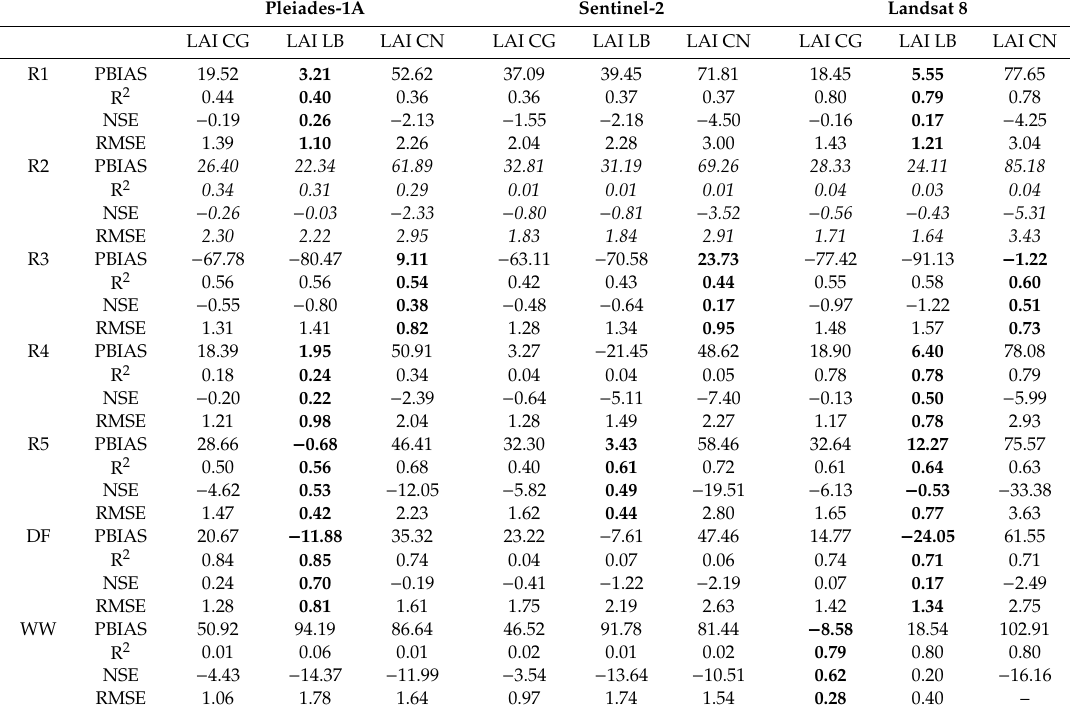
Table 3. Comparisons between the observed Leaf Area Index (LAI obs ) and LAI values retrieved from remote sensing using three di ff erent satellite images and three equations (CG, LB, and